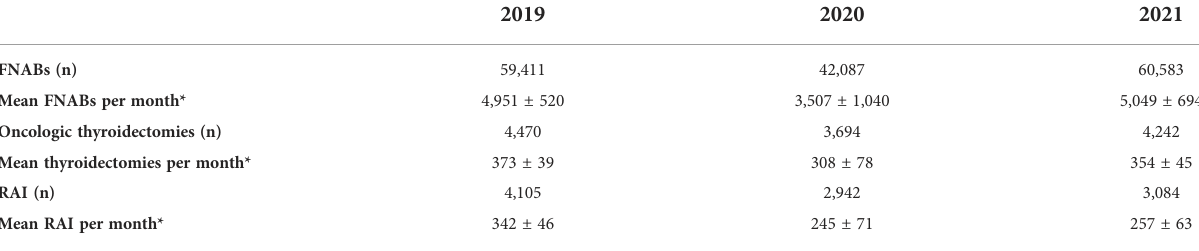
TABLE 1 Number of fi ne-needle aspiration biopsies, oncologic thyroidectomies, and radioiodine therapies in 2019, 2020, and 2021.